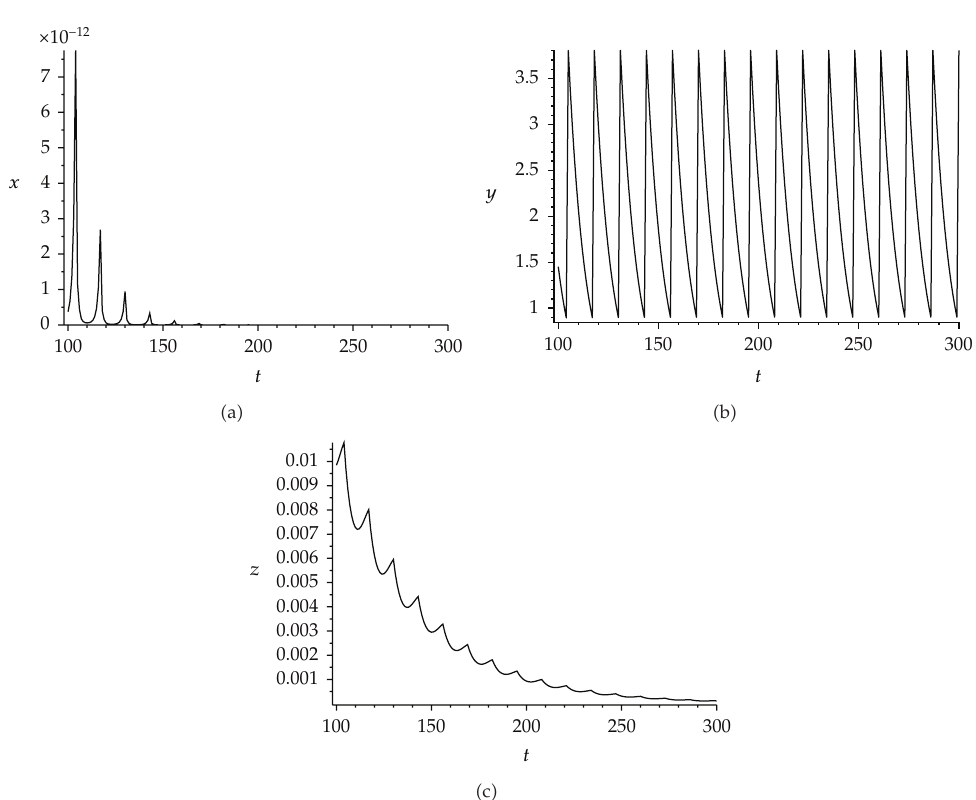
Figure 2: Dynamics of system (cid:5) 1.3 (cid:6) with a (cid:7) 1 . 72, b (cid:7) 0 . 52, c 1 (cid:7) 0 . 83, c 2 (cid:7) 0 . 64, c 3 (cid:7) 0 . 23, c 4 (cid:7) 0 . 32, c 5 (cid:7) 0 . 76, c 6 (cid:7) 0 . 48, e 1 (cid:7) 0 . 56, e 2 (cid:7) 0 . 62, d 1 (cid:7) 0 . 12, d 2 (cid:7) 0 . 25, T (cid:7) 13, p (cid:7) 4 . 2, and q (cid:7) 0 . 9. (cid:5) a (cid:6) time series of prey, (cid:5) b (cid:6) time series of intermediate predator, and (cid:5) c (cid:6) time series of top predator.